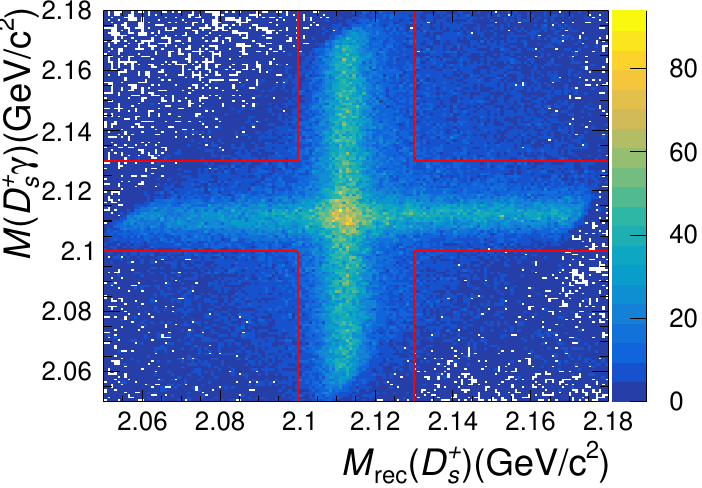
Figure 1 . Two-dimensional distribution of the recoil mass of D + for the decay D + ! K + (cid:25) 0 , where the solid lines denote the boundaries for the horizontal and s vertical band